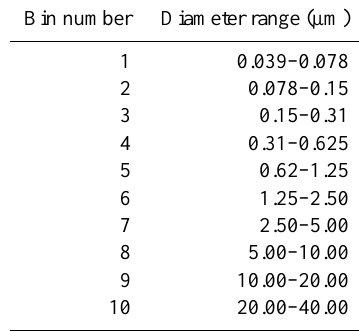
Table 1. Sectional bins for